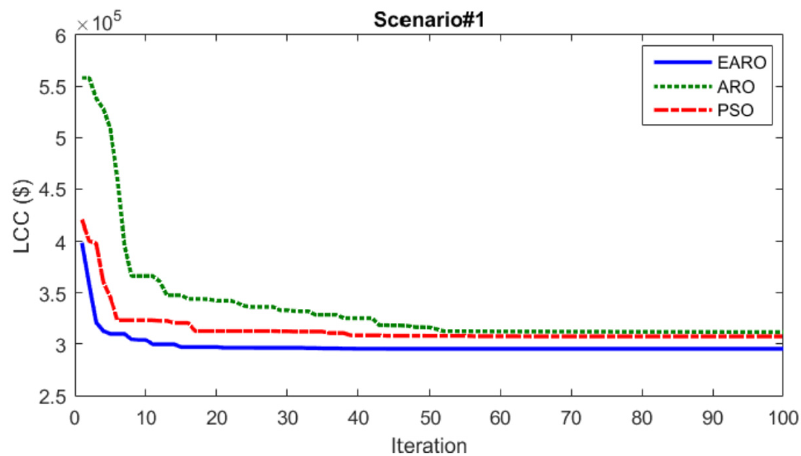
Figure 7. The EARO, ARO, and PSO convergence curves in the first scenario. Figure 6. The EARO, ARO, and PSO convergence curves in the first scenario. Table 6. System optimization results in the first scenario. Table 6. System optimization results in the first scenario. Method/Parameter